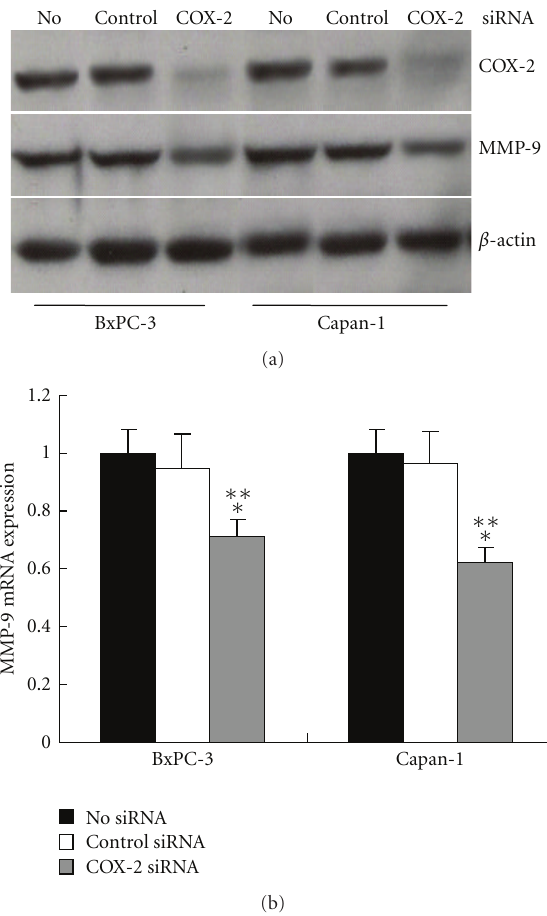
Figure 4: Downregulation of MMP-9 by COX-2 siRNA (a) Western blotting revealed expression of COX-2 was absent in BxPC-3 and Capan-1 after transfection with COX-2 siRNA plasmid. (b) After transfection with COX-2 siRNA plasmid, MMP-9 mRNA expression was downregulated significantly in BxPC-3 and Capan- 1 cells, compared with cells with control siRNA ( ∗ P < 0 . 001, resp., versus control siRNA) or cells without siRNA ( ∗∗ P < 0 . 001, resp., versus no siRNA). Data are expressed as mean ± SD, n = 3.